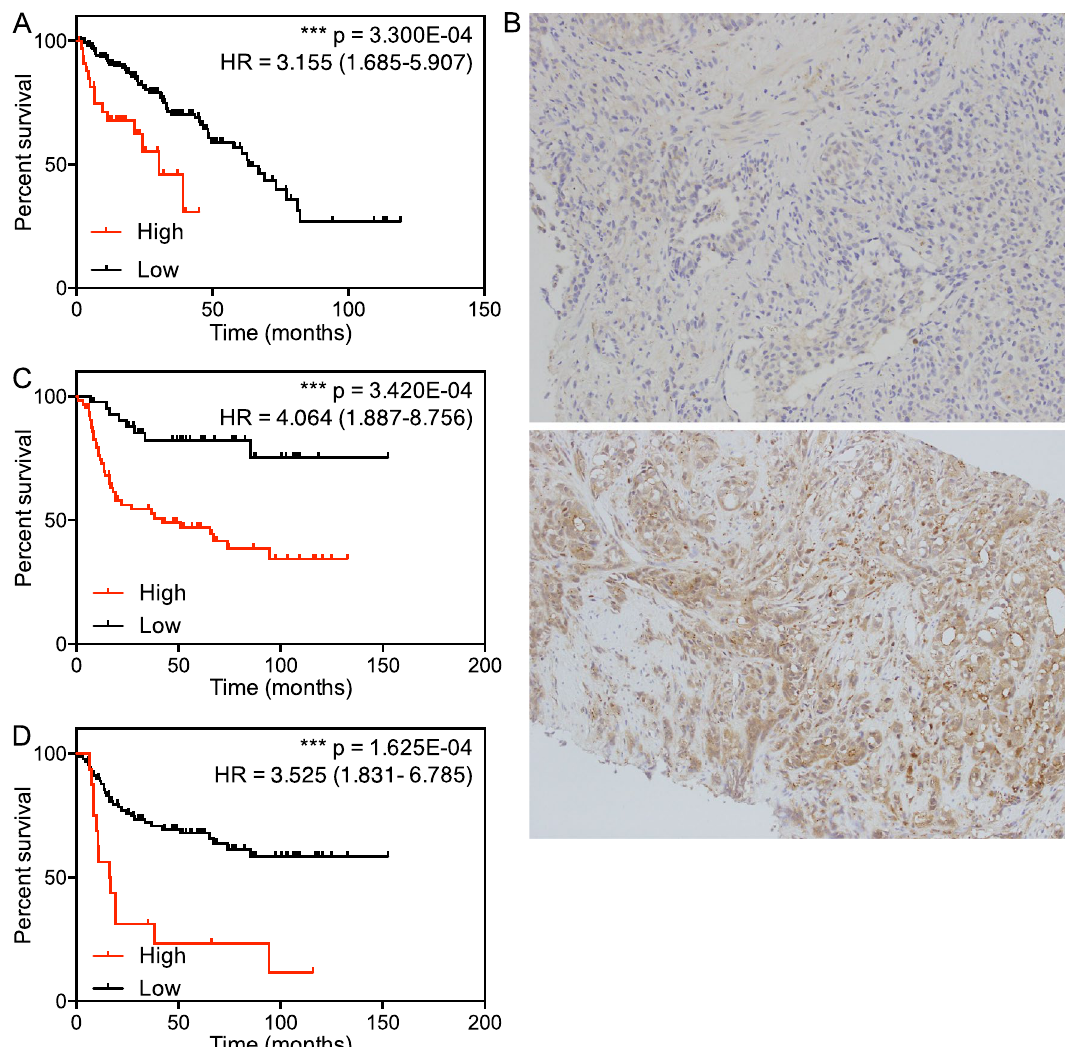
Figure 1. Effect of GRB2 expression on survival. ( A ) Recurrence-free survival curves for prostate cancer patients in the TCGA dataset. Each population was divided into two groups according to the cutoff point defined by Cox regression model (cutoff z-score = 1.0951). ( B ) Representative images of prostate cancer biopsy samples showing low (top) or high (bottom) expression of GRB2 protein. C and D. Recurrence-free survival curves for prostate cancer patients in the local clinical cohort. Each population was divided into two groups according to the cutoff point defined by the Cox regression model (cutoff H-score = 69.8592) ( C ) and a z-score = 1 ( D ).